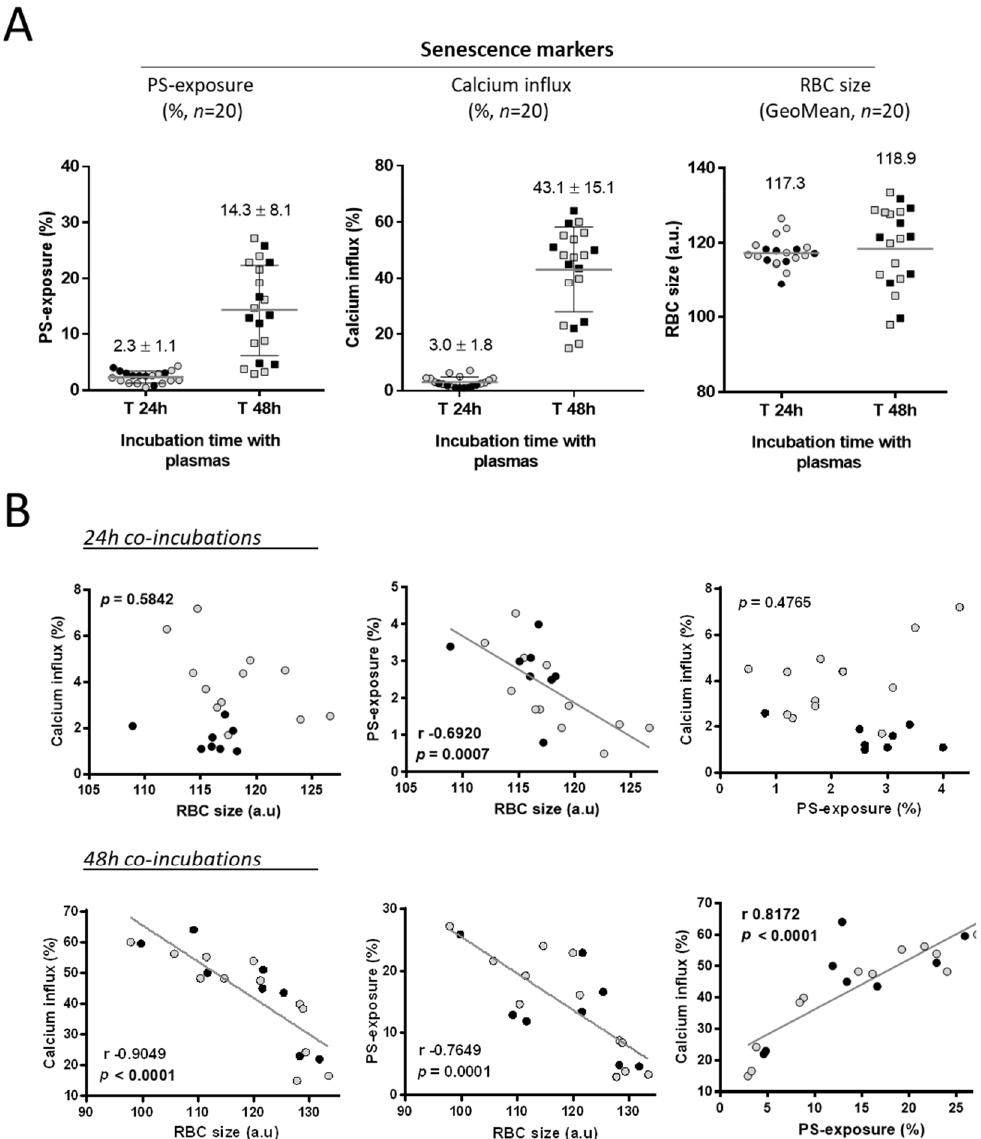
Figure 2. Markers of senescence detected on RBCs after co-incubations with SCD patient plasmas and correlations between changes in senescence markers for senescence on AA RBCs after 24-h (upper panel) and 48-h (lower panel) co-incubations. ( A ) AA RBCs from blood units and the patient plasmas ( n = 20) were used for co-incubations together at +37 ◦ C for T 24 h and T 48 h. The senescence markers were the following: the PS-exposure on red cells (Annexin V FITC positive cells, %), the level of calcium influx into red cells (Fluo3/AM staining; %) and the reduction in RBC size attested by the FSC GeoMean parameter (arbitrary units), all by flow cytometry. We represented the results for the 20 individual SCD plasma samples for whom we had collected data for the three senescence markers. The mean values obtained (% ± SD for PS-exposure and calcium influx) or the GeoMean (for the RBC size) are represented on each graph. ( B ) The plots represent the Pearson correlations (r; p ) after linear regression of the different parameter combinations, by using the data shown in Figure 1: the relative RBC size (FSC GeoMean parameter) and the calcium influx into red cells (%; Fluo3/AM parameter), the RBC size and the PS-exposure (%) (Annexin V-FITC positive staining) the PS-exposure (%) and the calcium influx into red cells (%). Each dot represents the plasma from an individual SCD patient; using the same data used in Figure 1, and a distinction is made between samples obtained from SCD patients in a basal steady state (light-grey circles) compared to SCD patients in a painful acute-phase (black circles) of the disease. Linear regressions and the correlations possibly existing between the senescence markers were tested using the Stata software.